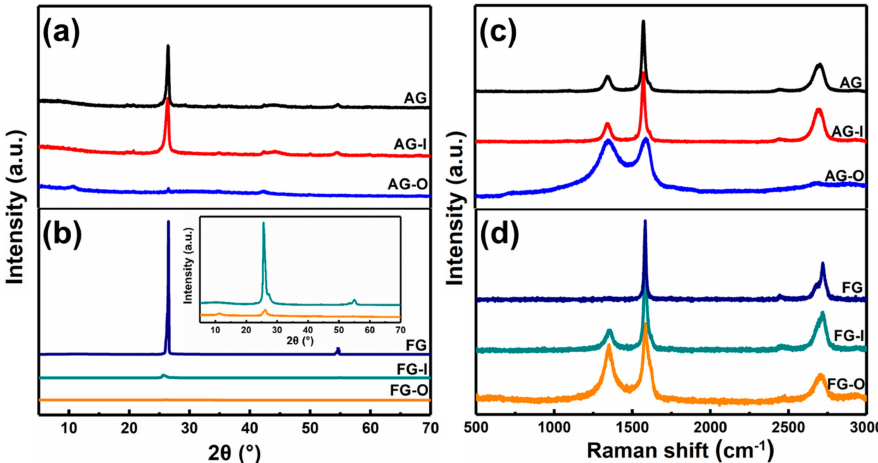
Figure 3. ( a ) XRD patterns and ( c ) Raman spectra of AG, AG-I, AG-O. ( b ) XRD patterns and ( d ) Raman spectra of FG, FG-I, and FG-O. Table 1. Comparation of XRD and Raman data of AG and FG during exfoliating.